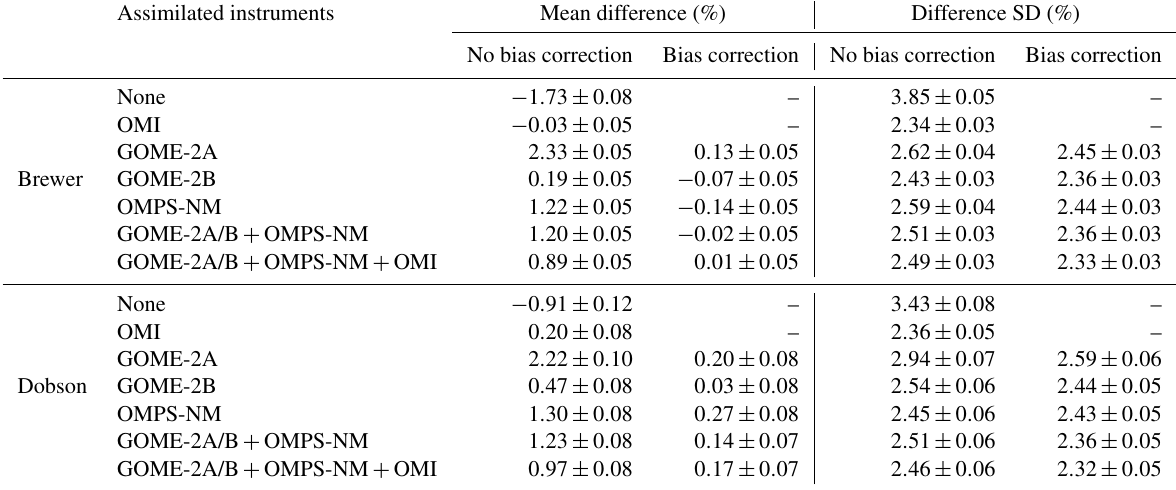
Table 6. Global mean differences (%) between Brewer and Dobson total column ozone measurements and short-term forecasts for July– August 2014. For bias-corrected observations, the colocated observation bias-correction scheme (Sect. 4.1) was used. The Dobson measure- ments used were adjusted as a function of the ozone effective temperature (see Sect. 2.4). The uncertainties denote the standard error of the mean differences or standard deviations (SDs) of the differences. The data from the two Antarctic stations have been included here even though their mean differences with OMI are outliers relative to most mean differences (Tables S1 and S2 in the Supplement). Assimilated instruments Mean difference